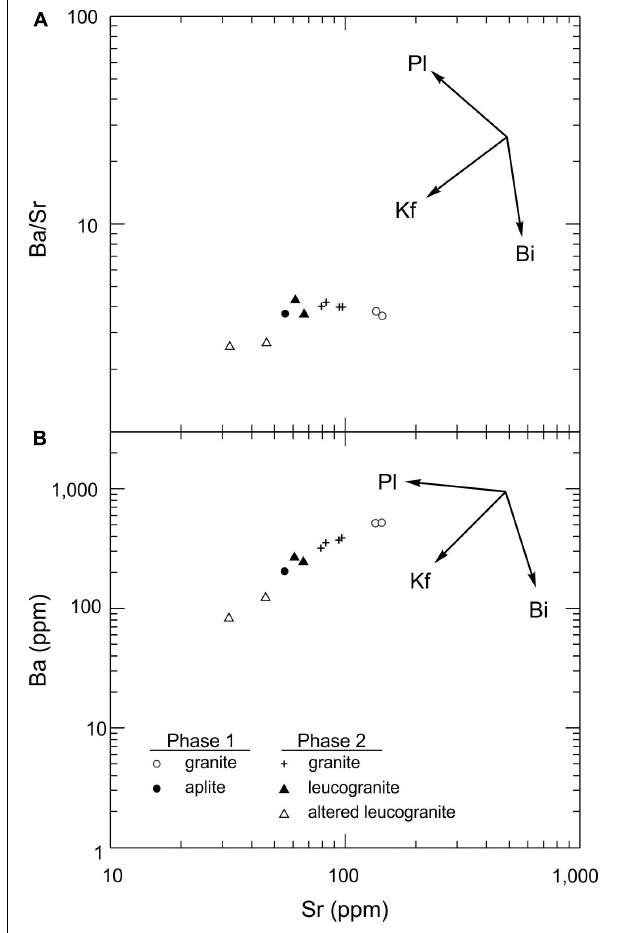
FIGURE 12 | (A) Ba/Sr and (B) Ba versus Sr (in ppm) diagrams for the granitic rocks of the Tukham pluton. Vectors depict the fractionation trends of the compositional changes in the residual liquid when the specified phase is progressively removed from the magma during fractional crystallization; Pl—plagioclase; Kf—K-feldspar; and